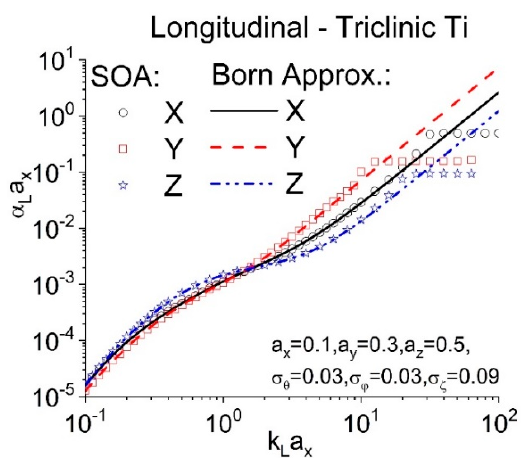
Figure 5. Comparison of the longitudinal attenuation results from SOA model and the Born approximation [40] for a textured polycrystal of triclinic Ti crystallites with main grain radii a X = 0.1 mm, a Y = 0.3 mm and a Z = 0.5 mm. The macrotexture parameters are σ θ = 0.03, σ φ = σ θ